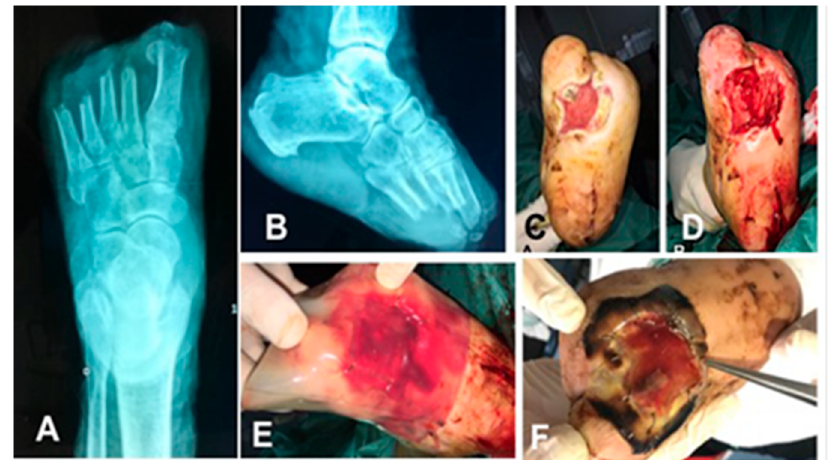
Figure 1. The plain radiograph of foot ( A , B ), a midfoot plantar injury on enrolment ( C ) and after debridement with hydro surgery system ( D ), treatment with IDRT (Integra ® Dermal Regeneration Template) fixed with metal clips ( E ), clinical examination at T1 ( F ).